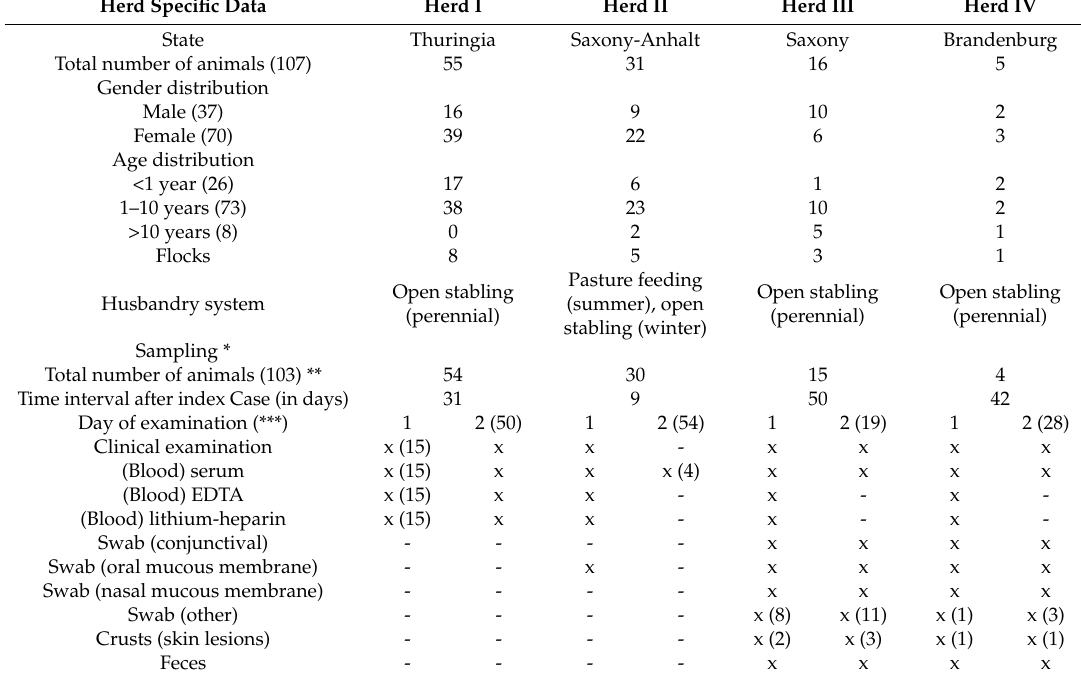
Table 1. Herd specific data and sampling